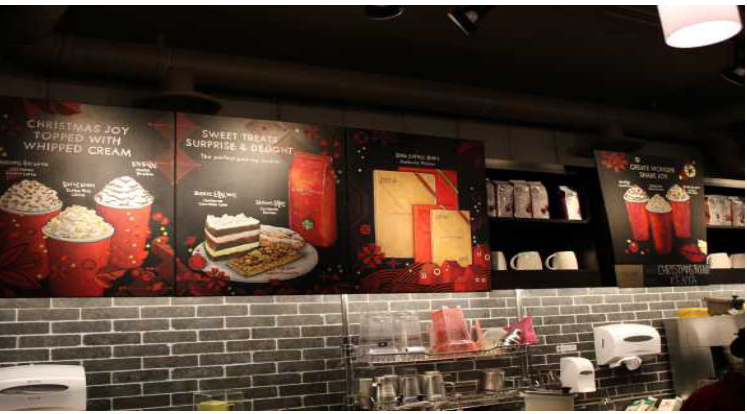
Figure 17. Starbucks’seasonal menu [68].